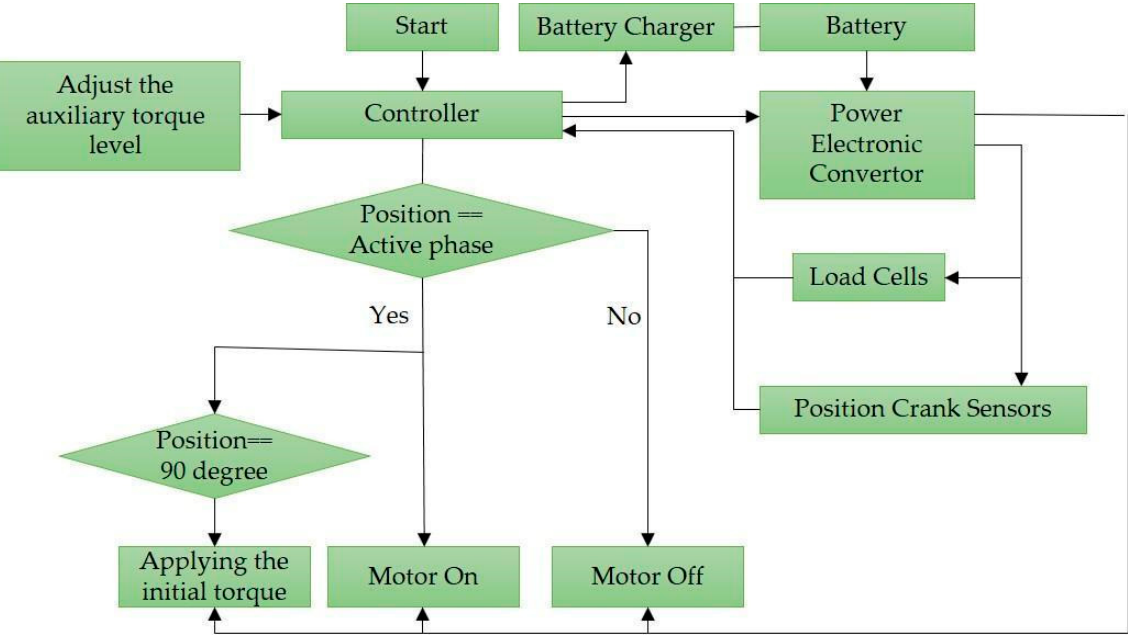
Figure 2. APAD motor controller flowchart.